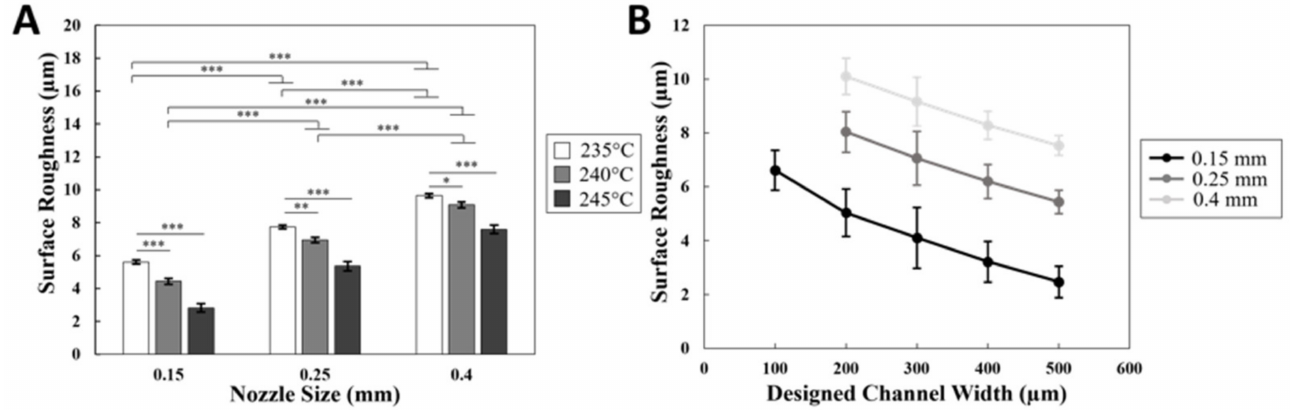
Figure 4. Surface roughness of printed channels. A Mitutoyo profilometer (Mitutoyo SJ-210, Japan) was used to characterize the surface roughness of the printed channels. ( A ) The roughness decreases with increasing nozzle temperatures and smaller orifice sizes. ( B ) Surface roughness decreases with increasing channel width and smaller orifice sizes. Error bar S.E.M (N = 3), * p -value < 0.05, ** p -value < 0.01, and *** p -value <